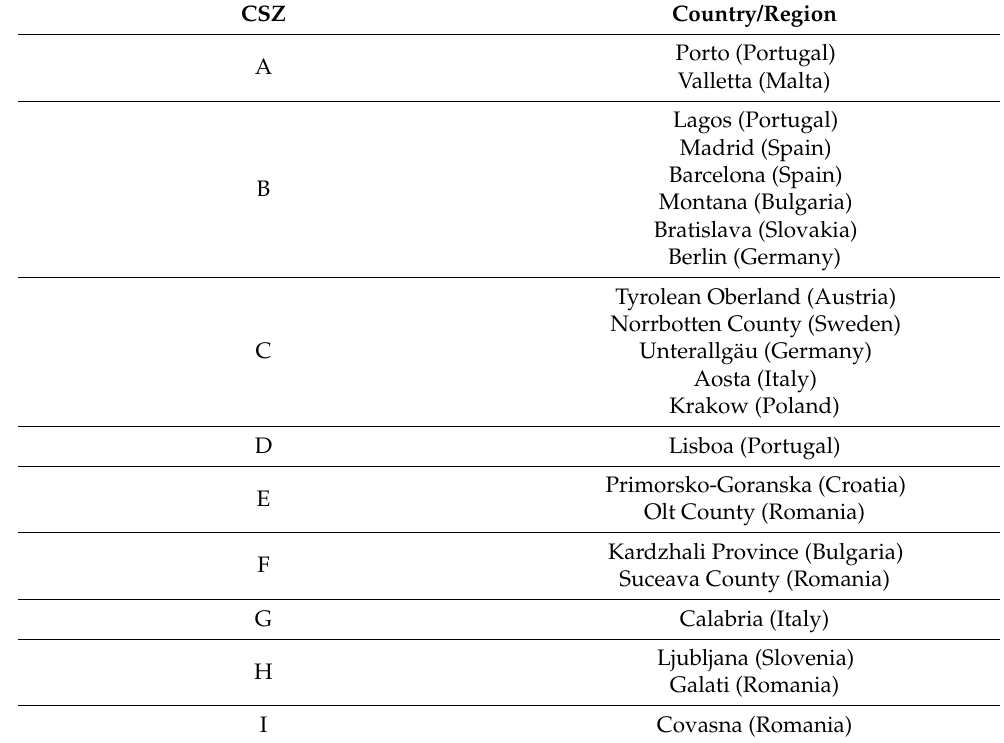
Table 3. List of relevant regions for each seismic–climate zone.